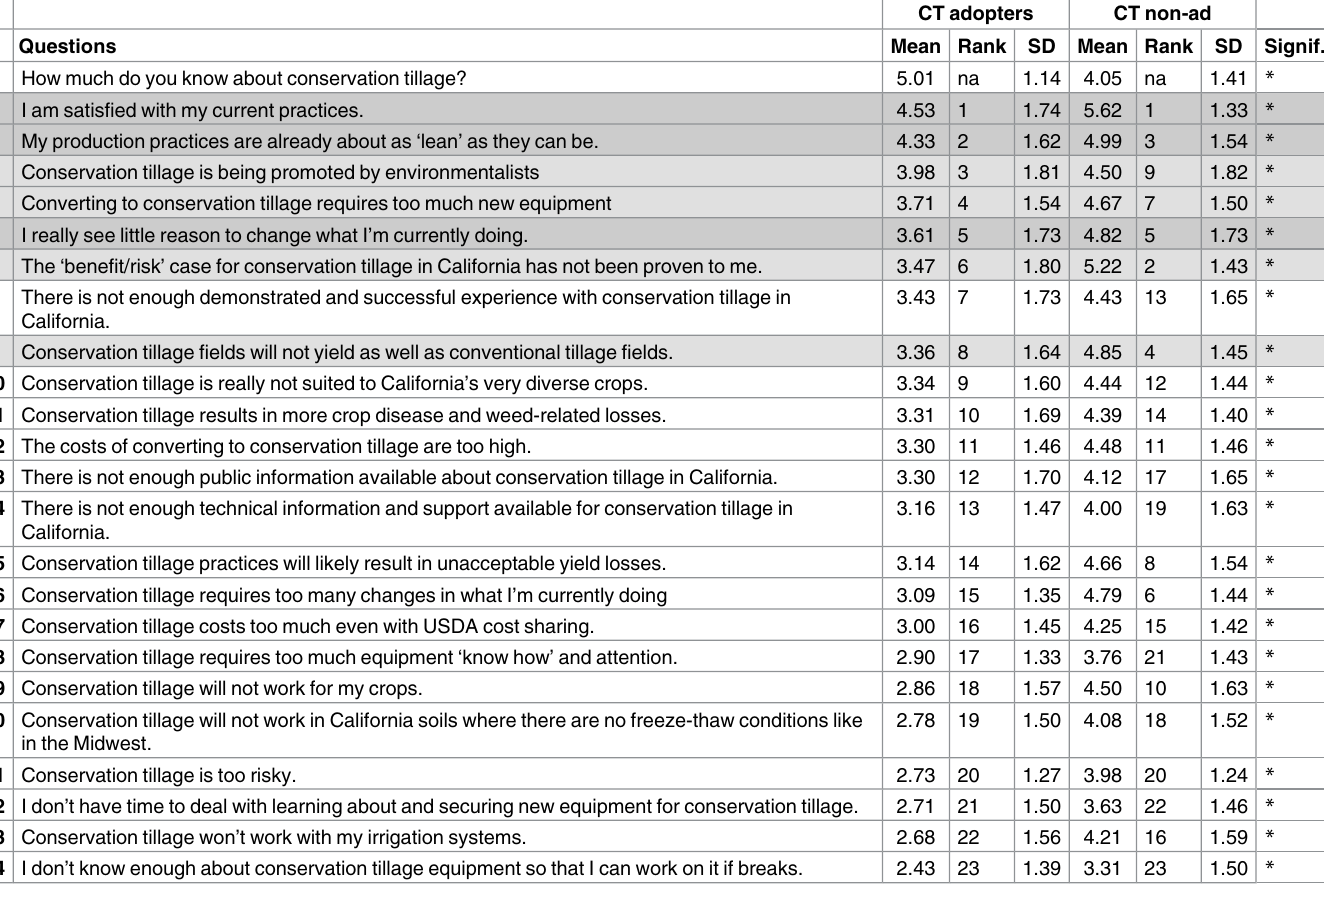
Table 2. Farmer ‘beliefs’ about conservation tillage. Farmers were asked to ‘pleaserespondto the followingstatements based on what you ‘believe’ about conservation tillage ... ‘1’ is strongly disagreeand ‘7’ is strongly agree.’ Responsesfor adopters of CT and non-adopters of CT were ranked with gray boxes representingthe top ranked